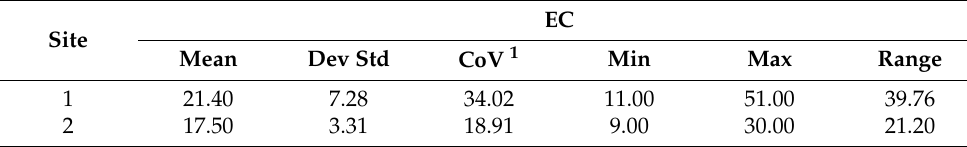
Figure 3. Resistivity map of the first site (Matera on the left) and of the second site (Genzano). Table 5. Descriptive statistics of EC for both